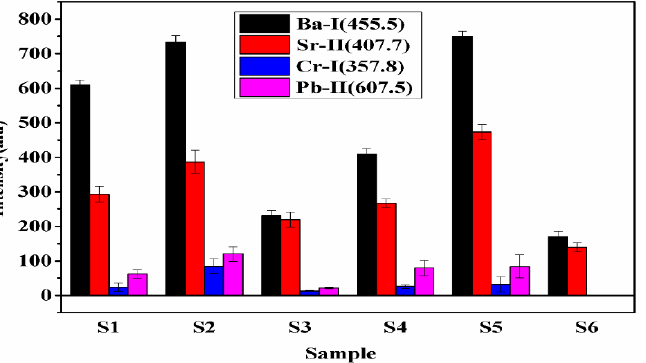
Figure 6. The integrated intensities of the spectral line of Ba, Sr, Cr, and Pb elements in the samples. Sample S5 is a local manufacturer of turmeric products, and the market price of this brand is less compared to the other brands. It might be the main motive of this brand is to provide turmeric powder at a low price to beat the other products available in the market. Thus, sample S5 may contain the adulteration of metanil yellow having molecular formula C 18 H 14 N 3 NaO 3 S. which is a toxic azo dye to mimic the appearance of curcumin (C 21 H 20 O 6 ) when actual curcumin contain is low. The intensity of the spectral lines of Na, C, H, N, and O in sample S5 is higher (Figure 7) as compared to other samples, which reveals that the contents of metanil yellow (C 18 H 14 N 3 NaO 3 S) are large in S5. We also see that sample S6 contains more curcumin (C 21 H 20 O 6 ) as this turmeric sample is natural as it is collected homegrown without any adulteration. By comparing the spectral intensity of C, N, O, H, Pb, Cr, and Na shown in Figures 6 and 7, we can say that sample S5 is contaminated with metanil azo dye as well as with lead chromate, and sample S2 contain lead chromate whereas sample S6 is pure and natural turmeric powder that contains more curcumin. Curcumin has many scientifically proven health benefits, such as the potential to improve heart health and prevent Alzheimer’s and cancer. It is a potent anti-inflammatory and antioxidant and may also help improve symptoms of depression and arthritis. Thus, sample S6 may be used as herbal medicine, in addition to its use as a spice.